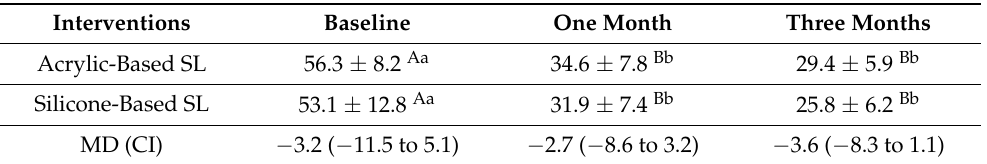
Table 2. The overall oral health-related quality of life (Mean ± SD) at baseline and one and three months after denture